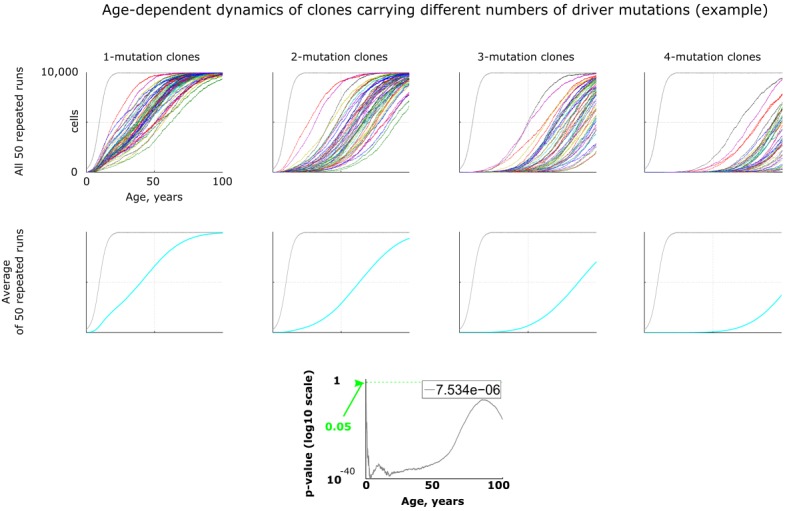
An example of age-dependent clonal dynamics generated by the model.All results, except Figure 5, were generated by running 50 repeated simulation runs with identical parameters. Results in Figures 3–4 are represented as averaged dynamics of the 50 repeated simulation runs. Two types of statistical comparisons were done: a) the effect of changing a parameter in question (e.g. mutation rate) was compared within each type of clones, that is for 1-, 2-, 3- or 4-mutation clones (not shown in this figure); b) alternatively the difference between different types of clones was measured within one identical parameter set (lowermost chart in this figure). P-values in both types of statistics were calculated by comparing samples of 50 clones either for different parameter values within one clone type or for different clone types for one identical parameter set by applying the Kruskal-Wallis test, which is non-parametric analog of ANOVA. The number in top right corner of each p-value chart was derived by dividing the sum of all p-values along the age axis (area under p-value curve) by 5200 (maximum of Y-axis multiplied by maximum of X-axis, which represents the total area of the chart) as explained in Materials and methods.